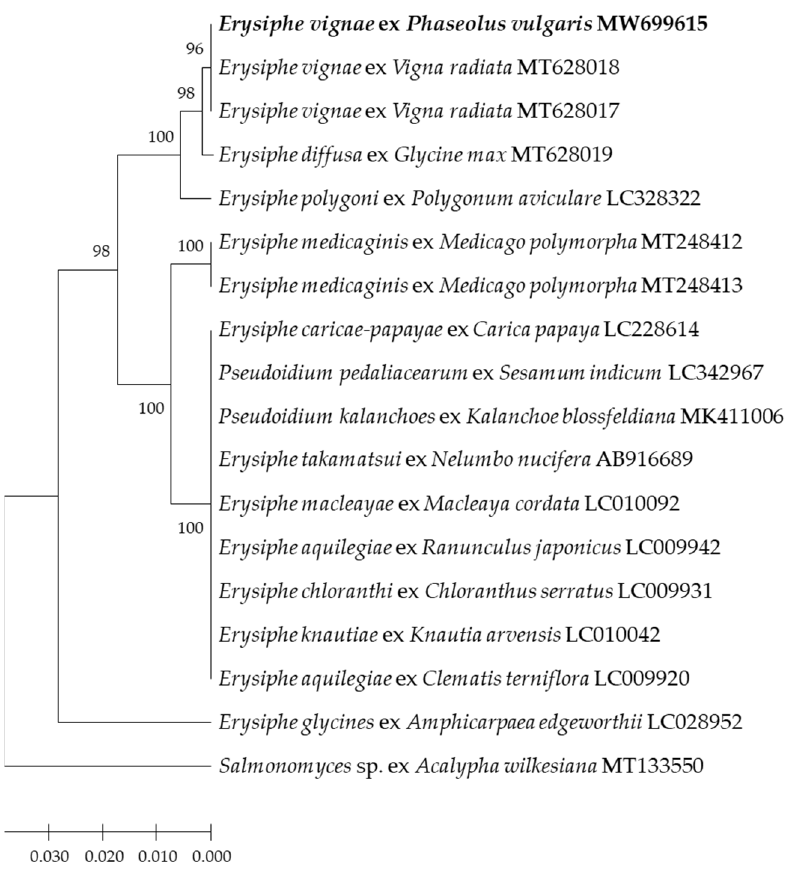
Figure 4. Phylogenetic tree inferred from Neighbor-joining analysis of the LSU sequences in this study and GenBank (Table 1). The tree is rooted to the LSU sequence of Salmonomyces javanicus (MT133550). Table 1. Powdery mildew species used in the phylogenetic analyses.